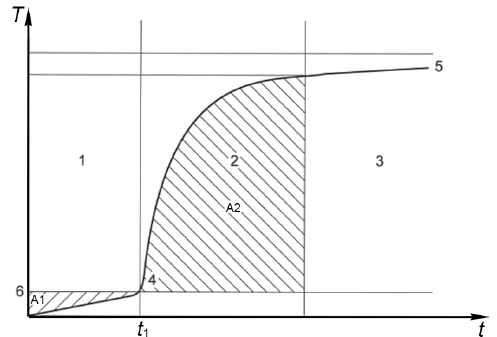
Fig. 9. Temperature/time curve: T – temperature; t – time; 1 – preliminary period; 2 – main period; 3 – final period; 4 – igni- tion; 5 – temperature of the jacket; 6 – time when the tempera- ture of the water in the crucible vessel is equal to the tempera- ture of the